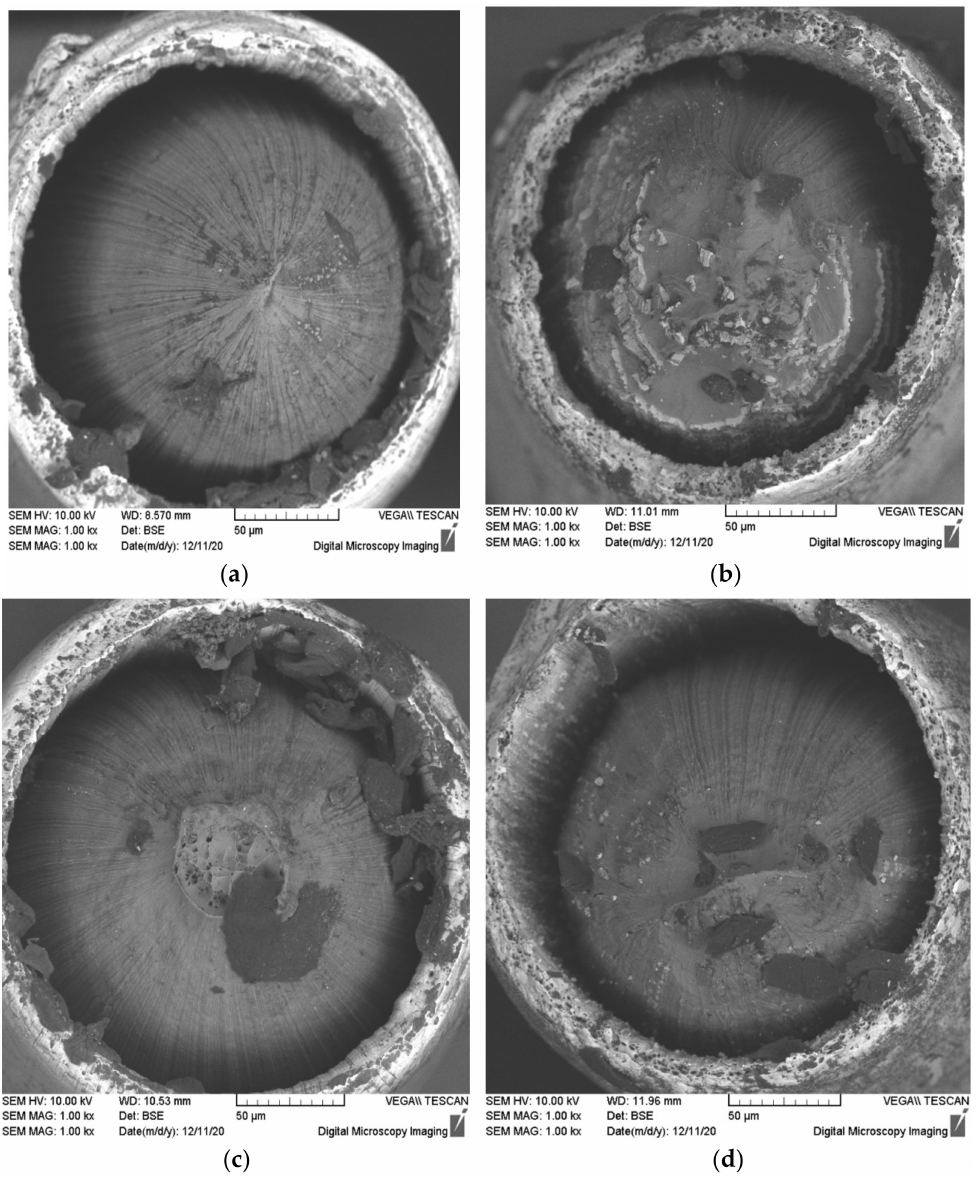
Figure 10. Fractographic analysis of the fractures of the sample bimetallic wires from Alloy #1 ( a , b ) and from Alloy #3 ( c , d ) after the tension tests: ( a , c ) without annealing; ( b , d ) and annealed at 500 ◦ C for 30